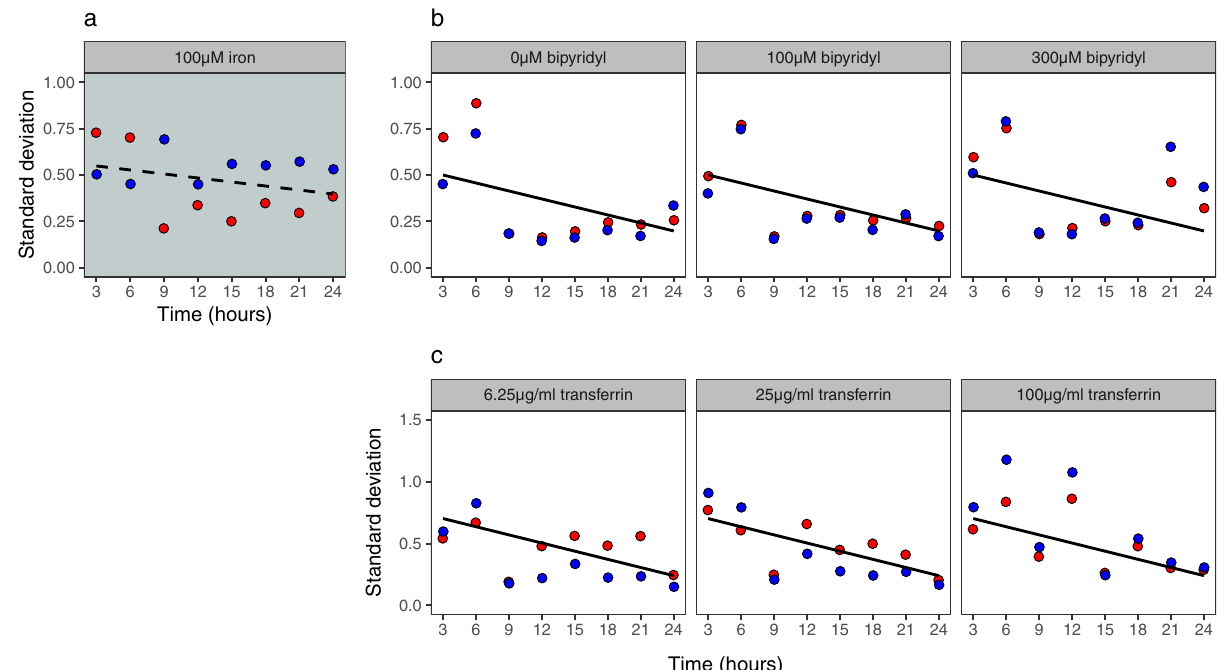
Fig. 4 Heterogeneity in siderophore gene expression declines over time. Temporal heterogeneity in siderophore gene expression for pyochelin (red: pchEF ) and pyoverdine (blue: pvdA) , measured with the double reporter strain PAO1 pvdA :: mcherry – pchEF :: egfp across a range of CAA media differing in their levels of iron limitations. Heterogeneity in gene expression is shown as the standard deviation across log-transformed fl uorescence values of all cells. a Iron-replete CAA medium (100 µ M FeCl 3 ); b CAA media with increasing concentration of the iron chelator bipyridyl; c CAA media with increasing concentration of the iron chelator apo-transferrin. Solid black trendlines indicate signi fi cant declines in heterogeneity across